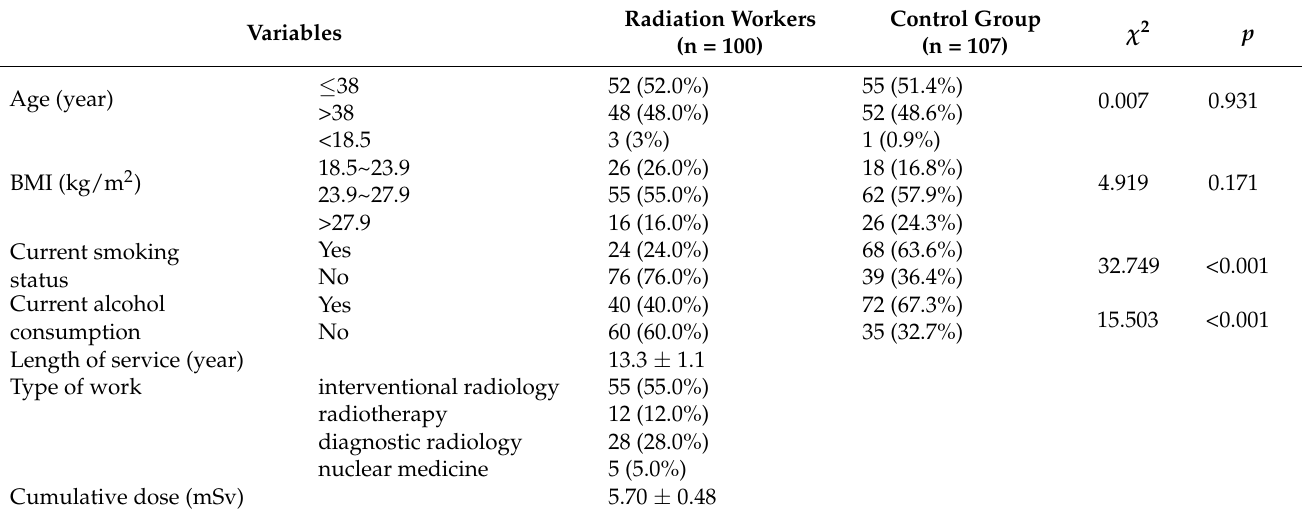
Table 1. Demographic characteristics of research objects.